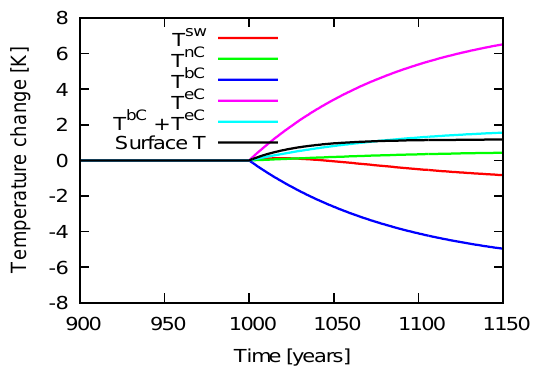
Fig. 9. As Fig. 8, but for changes relative to the year 1000, i.e. before the CO 2 doubling.